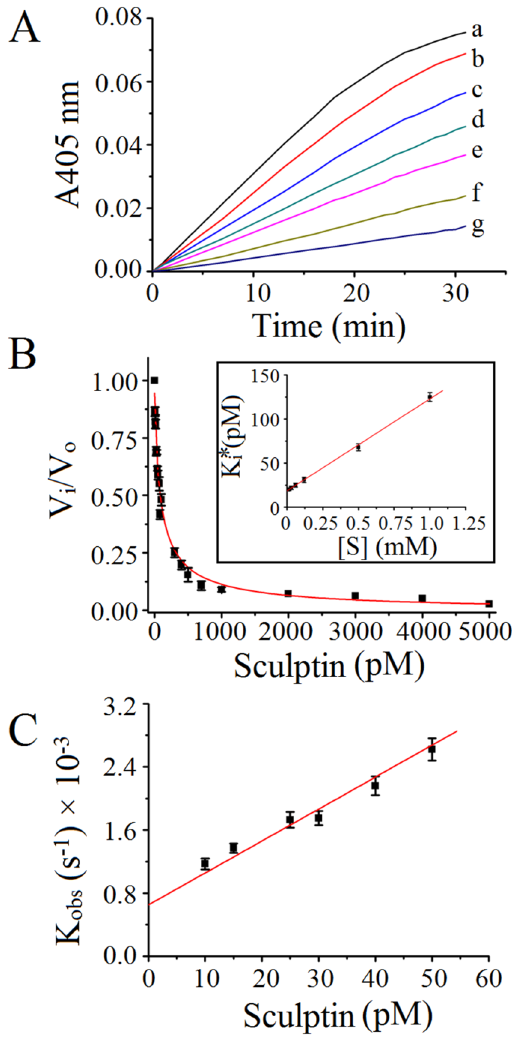
Figure 4. Relationship between the apparent first-order rate and the concentration of tight binding inhibitor sculptin. ( A ) Typical progress curves for hydrolysis of 15 µ M S-2238 chromogenic substrate by 0.1 nM thrombin in absence (trace a) and presence of sculptin (trace b, 10 pM; trace c, 30 pM; trace d, 70 pM; trace e, 100 pM; trace f, 200 pM and trace g, 500 pM) in 50 mM phosphate buffer containing 150 mM NaCl and 0.1% PEG 6000, pH 7.4 at 37 °C. Reactions were started with addition of thrombin to the mixture containing sculptin and S-2238. ( B ) Steady-state velocity of thrombin with respect to sculptin concentration. The inset shows the determination of the apparent dissociation constant, Ki * , from steady state velocities. The data was fitted into a linear regression to obtain Ki. ( C ) Calculation of the dissociation constant from k obs . Progress curves were produced with 15 µ M S-2238, 0–50 pM sculptin, and 100 pM thrombin. The apparent first-order rate constant was calculated using a nonlinear regression fit, where the intercept and slope is k on and k off respectively. The experimental condition of ( B ) and ( C ) is the same as ( A ). The data in ( B ) and ( C ) correspond to the mean ± standard deviation values acquired in five independent